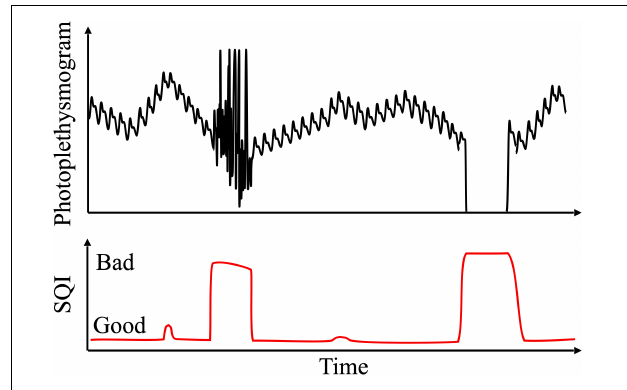
FIGURE 8 | Example of signal quality assessment using signal quality index